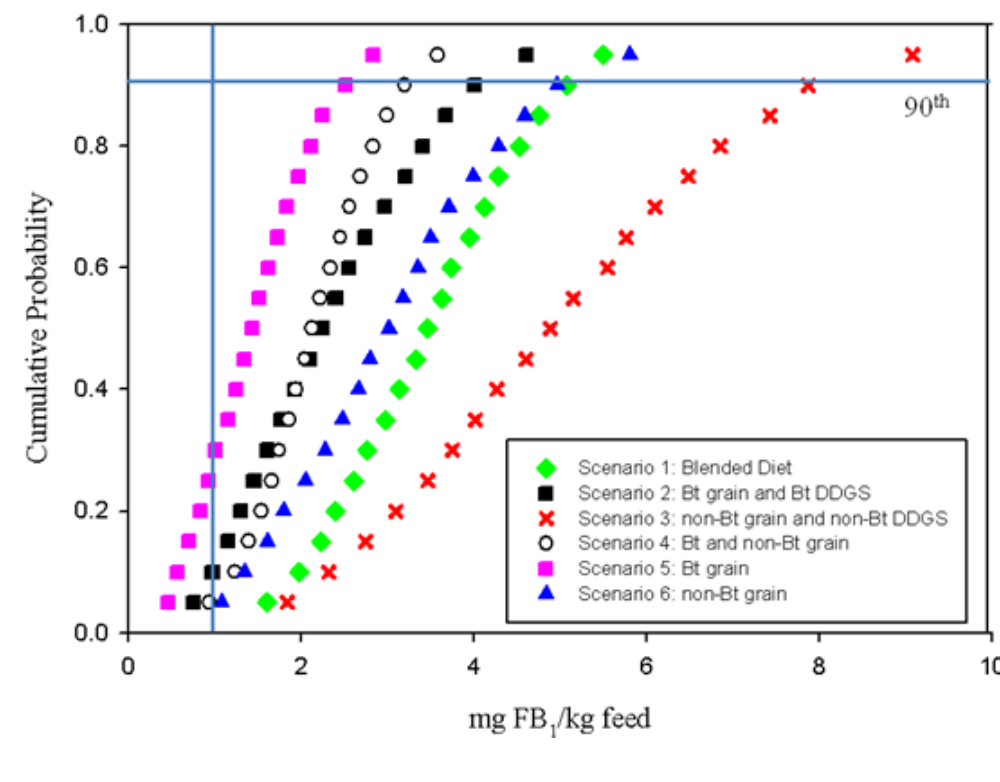
Figure 3. Cumulative distributions of chronic fumonisin B grower-finisher pig diet scenarios compared to the lower threshold of concern (1 mg FB /kg diet). Blended diet contains Bt grain, non-Bt grain, Bt DDGS, 1 non-Bt